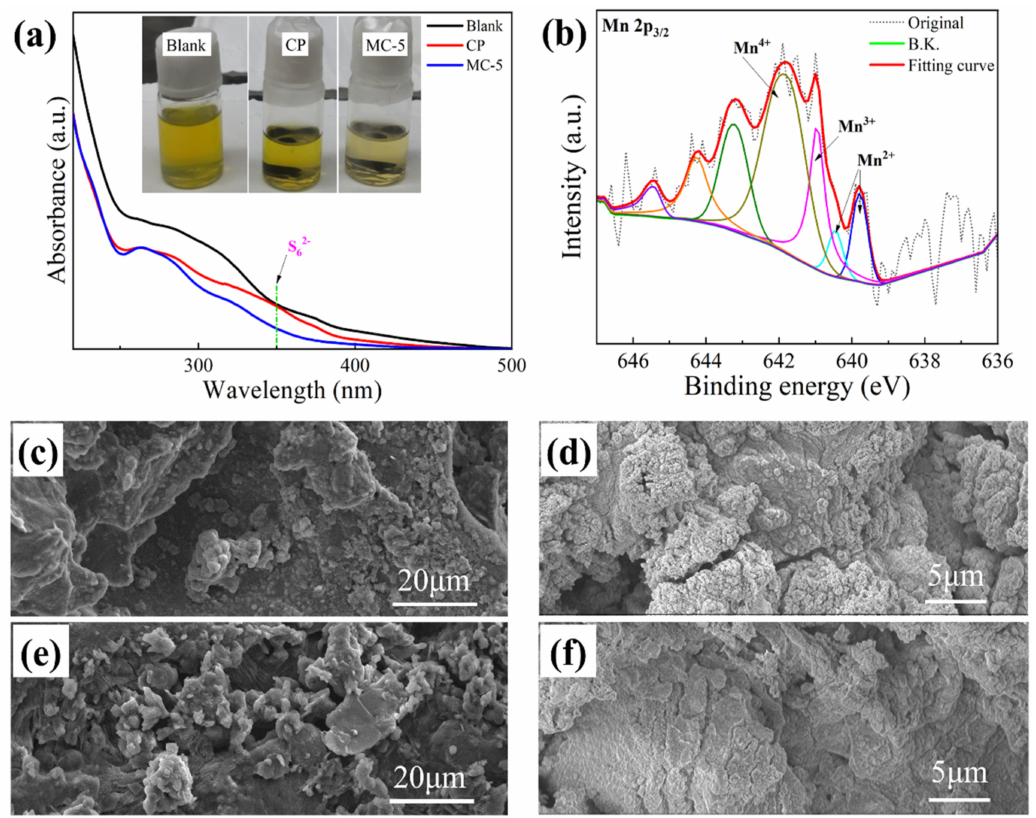
Figure 6. ( a ) Adsorption experiments of CP and MC-5 in Li 2 S 6 solution including the digital photos and UV–Vis spectra, and ( b ) Mn 2p 3/2 spectra of MC-5 after the adsorption experiment. SEM images of the cycled sulfur cathodes ( c , e ) and lithium anodes ( d , f ) from the Li–S batteries by using CP ( c , d ) and ( e , f ) MC-5 as